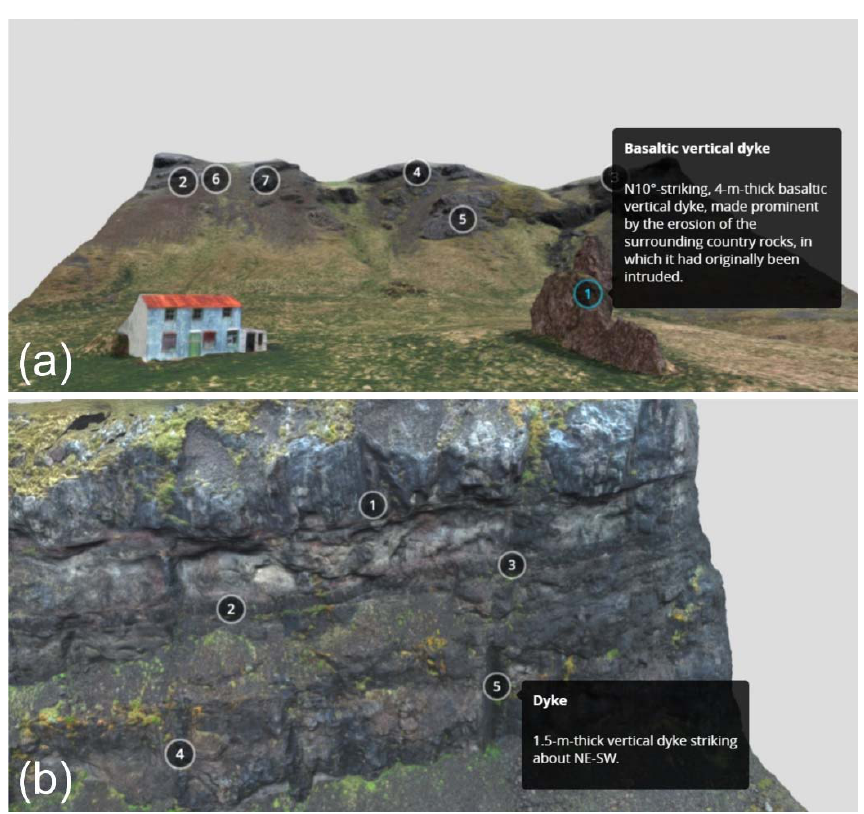
Figure 7. Example of an annotated virtual outcrop (VO) made available to the public showing shallow magma bodies ( a , b ) in eastern Iceland.